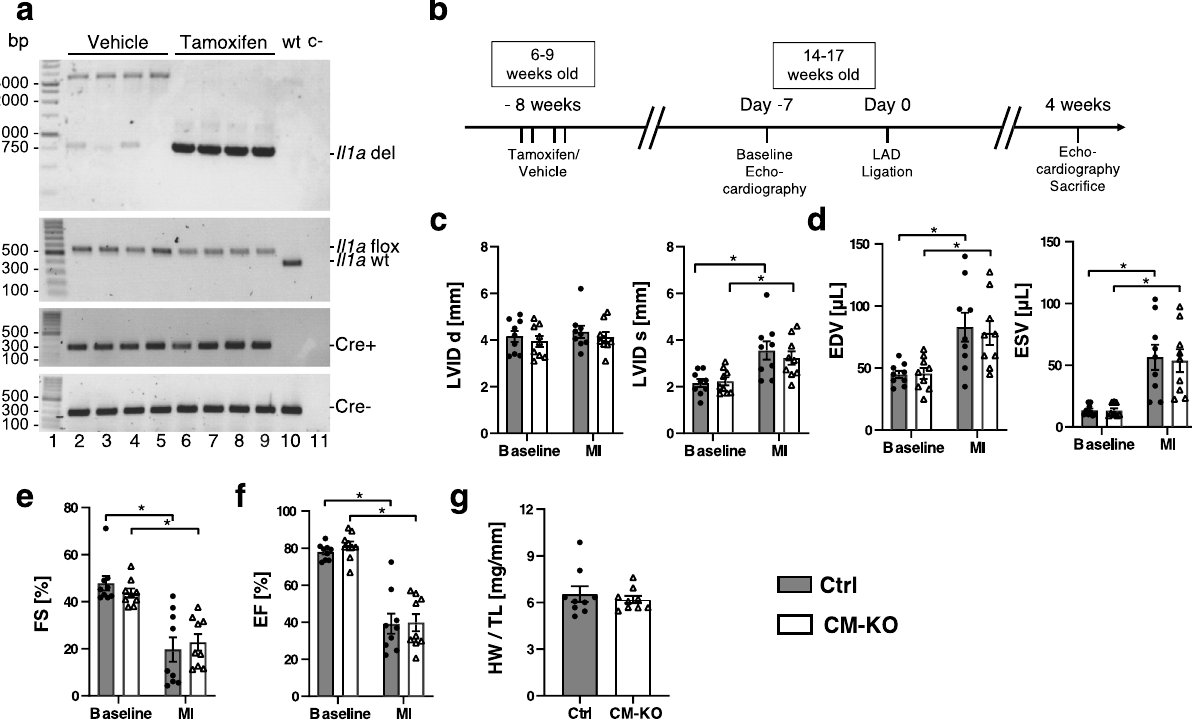
Figure 6. Specific IL-1α-deficiency in cardiomyocytes does not influence left ventricle remodeling four weeks after myocardial infarction. ( a ) Specific Il1a deletion in cardiomyocytes of Il1a fl/fl / Myh6 - Cre +/− mice treated with tamoxifen. ( b ) Timeline of tamoxifen-induced deletion, coronary ligation and echographic assessments. ( c ) Left ventricle inner diameter in diastole (LVID d) and systole (LVID s). ( d ) End diastolic (EDV) and end systolic (ESV) left ventricular volumes. ( e ) Left ventricular fractional shortening and (FS) and ( f ) ejection fraction (EF) at baseline and four weeks after MI. ( g ) Heart weight (HW) over tibia length (TL) ratio. N = 9 In vivo, at day 7 after MI, the absence of IL-1α did not influence the expression of TGFβ, the TGFβ receptor and the TGFβ decoy receptor BAMBI, a negative regulator of TGFβ signaling 31 . This is at variance with IL-1β, which has been shown to increase the expression of BAMBI and reduce the expression of the TGFβ co-receptor endoglin in CFs 31 , pointing to distinct actions of both IL-1 isoforms during the proliferative phase of healing after MI. With respect to SMAD2/3, we found that its phosphorylation status was greater in IL-1α KO mice after MI. However, the relative increase of SMAD phosphorylation after MI was significantly lower than in WT mice, owing to the presence of a slightly higher baseline (sham) level of phosphorylated SMAD in IL-1α KO mice. Therefore, while IL-1α does not have direct effects on TGFβ signaling in vitro, it may contribute to promote SMAD phosphorylation after MI in vivo, through mechanisms which remain to be elucidated. Furthermore, IL-1α KO mice displayed a significant reduction of genes involved in pro-fibrotic response after MI (Day 3 and especially Day 7). These genes included Acta2 , which encodes for α-smooth muscle actin, the prototypical marker of differentiated myofibroblasts 32 , Ctgf (Connective tissue Growth Factor), a surrogate marker for activated fibroblasts 33 , as well as Col1a1 (type 1 collagen) and Postn (periostin), two important struc- tural proteins from the extracellular matrix 34 . Accordingly, IL-1α KO mice displayed significantly less collagen fibers deposition in the LV at 2 weeks after MI, implying that IL-1α promotes early pro-fibrotic changes in the healing myocardium. In addition to the aforementioned genes, IL-1α KO mice also had reduced expression of the hypertrophy gene Myh7 (β-myosin heavy chain) 35 , a finding consistent with the cardiac hypertrophy reported in transgenic mice overexpressing IL-1α 36 , as well as Nppb, which encodes for the B-type natriuretic peptide. The latter change was reflected by a marked decrease of the plasma levels of its N-terminal pro-hormone NT-proBNP, a surrogate biomarker of cardiac volume and pressure with prognostic implication during the progression of heart failure 37 . Altogether, these data indicate that IL-1α represents an important signal for early post-MI fibrotic and hypertrophic ventricular remodeling, leading to enhanced myocardial wall stress, an assumption that was further confirmed by the suppressed increase of heart weight at day 3 and day 7 after MI in IL-1α KO mice. On a functional standpoint, the reduction of early myocardial remodeling afforded by systemic IL-1α defi- ciency translated into a delayed amelioration of LV structure and function, as evidenced by less LV dilation and myocardial thinning, as well as slightly better preserved systolic function. These effects of IL-1 deficiency were observed in mice with large infarct size, known to be associated with significant LV remodeling 16 . These findings concur with a previous study by Abbate et al. in a similar model of permanent LAD occlusion, reporting that systemic deletion of the IL-1 receptor reduced LV remodeling and dysfunction seven days post-MI 38 . Also, the same investigators reported that Anakinra, an antagonist of the IL-1 receptor, favorably influenced LV remodeling 14 days after MI in human patients 39 . According to a recent study by Bageghni et al., these detrimental actions of